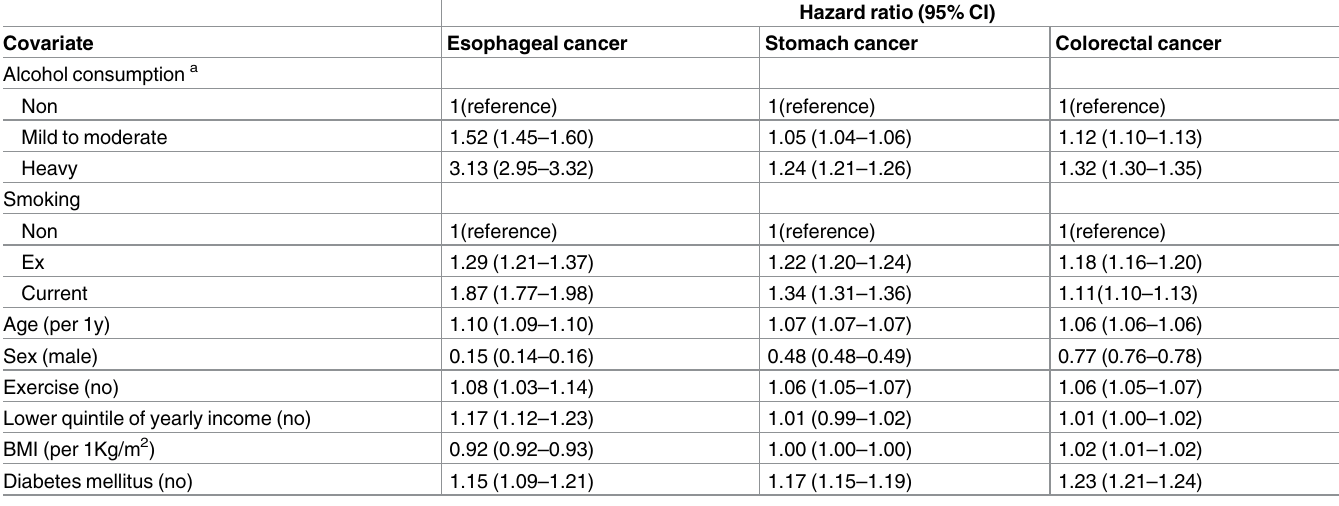
Table 2. Risk factors and adjusted hazard ratios of esophageal, stomach and colorectal